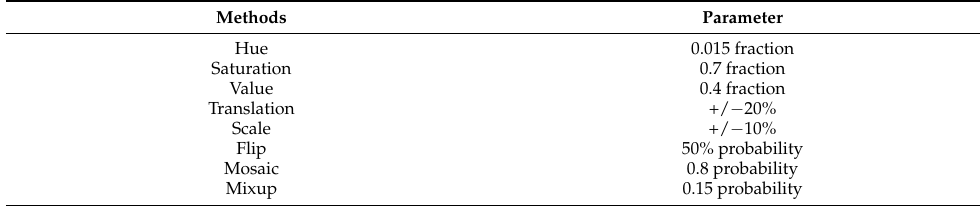
Table 2. The hyper-parameter of data augmentation.